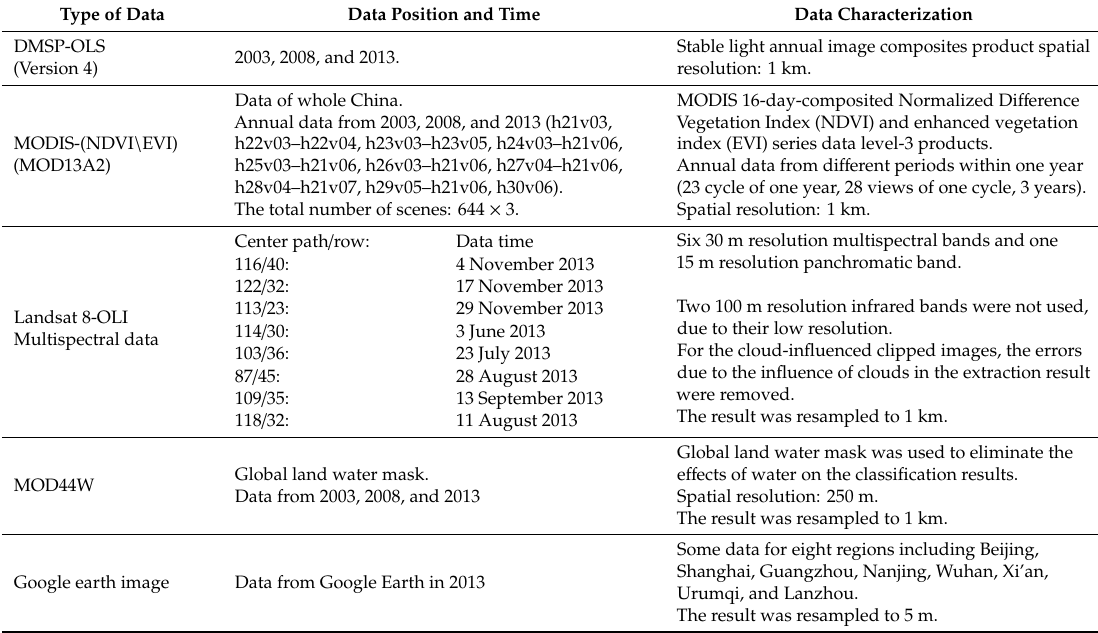
Table 1. Main types and characteristics of data used in this study. 157